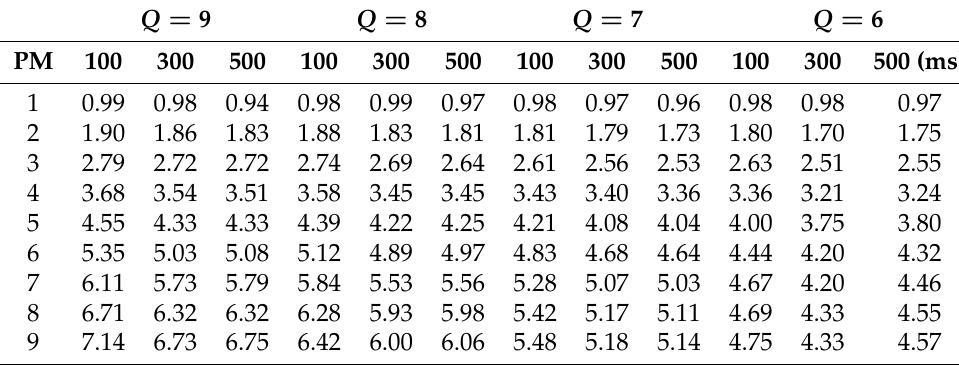
Table 2. The average number of PM neighbors.